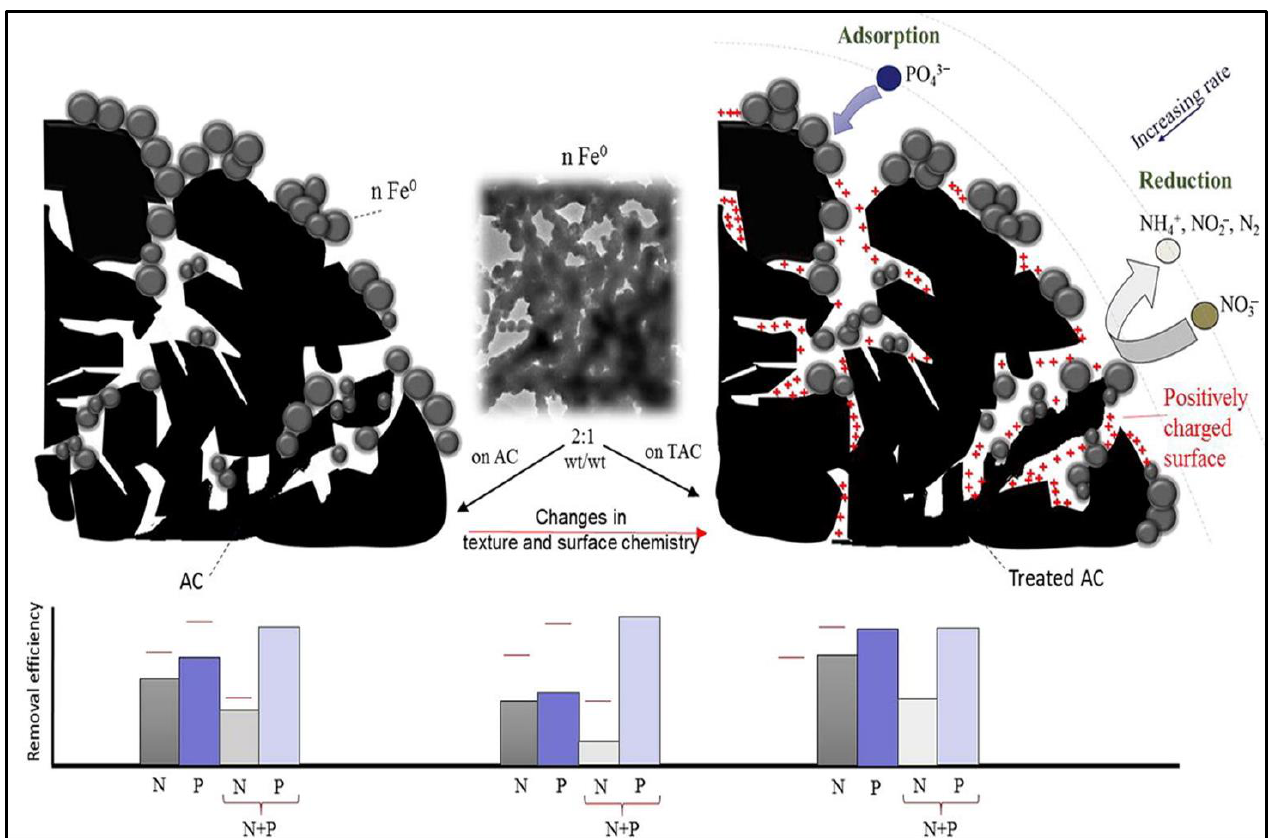
Figure 3. Schematic illustration of textile and surface chemistry modification of nano-scale zero- valent/activated carbon for the removal of nitrate and phosphate from water. The graphs show the removal efficiency of both nitrate and phosphate alone and combining together. Reprinted with permission from Ref. [69] , 2017, Elsevier.